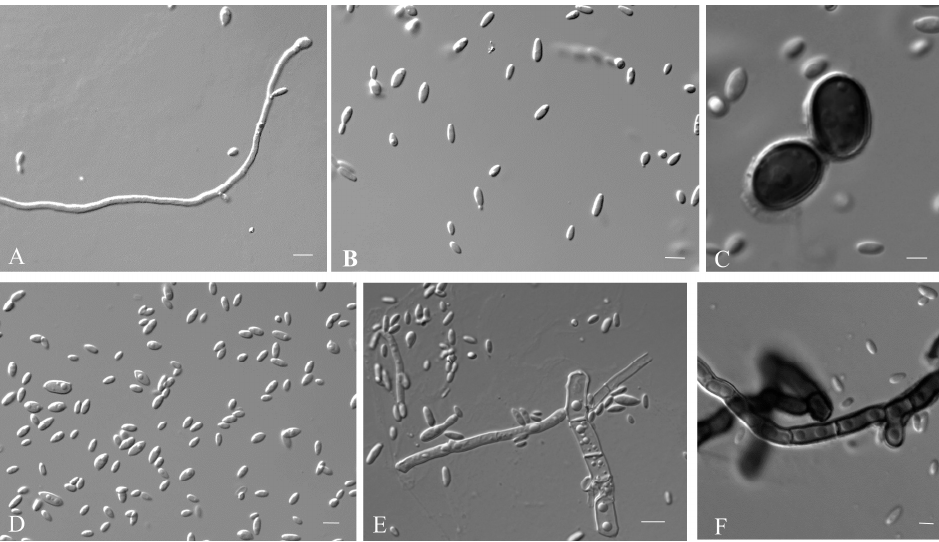
Figure 6. A. intercalariosporum (CGMCC 2.7208 ex-type culture). ( A , E ): Hyphae and conidiogenus cells. ( B , D ): Conidia. ( C , F ): Chlamydospores. Scale bars: ( A – F ) = 10 µm.